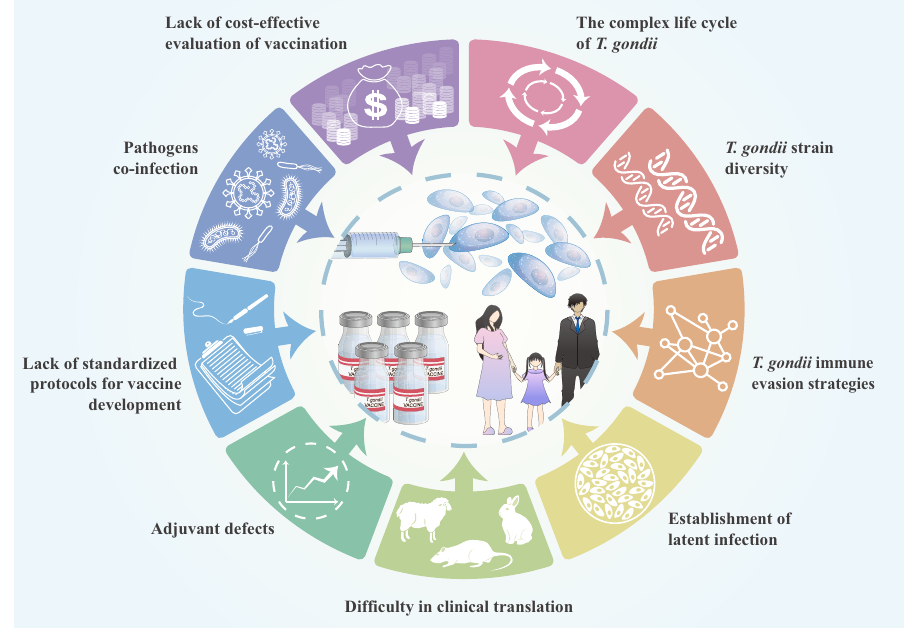
Fig. 2 Challenges in T. gondii vaccine